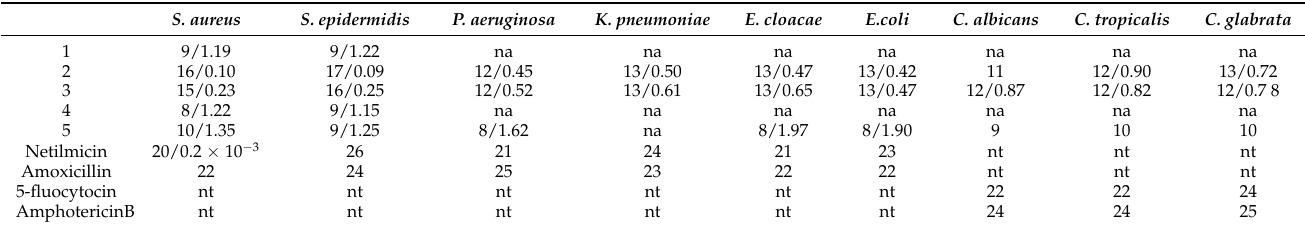
Table 2. Antimicrobial activity of the isolated compounds ( 1 – 5 ) (zones of inhibition/MIC mg/mL, n =